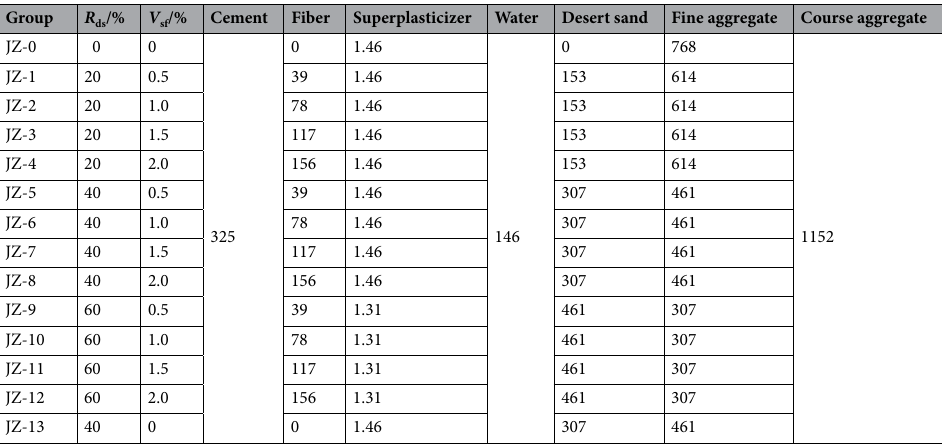
Table 3. Mix design of steel fiber reinforced desert sand concrete/(kg m −3 ). R ds means replacement rate of desert sand; V sf means volume content of steel fiber.